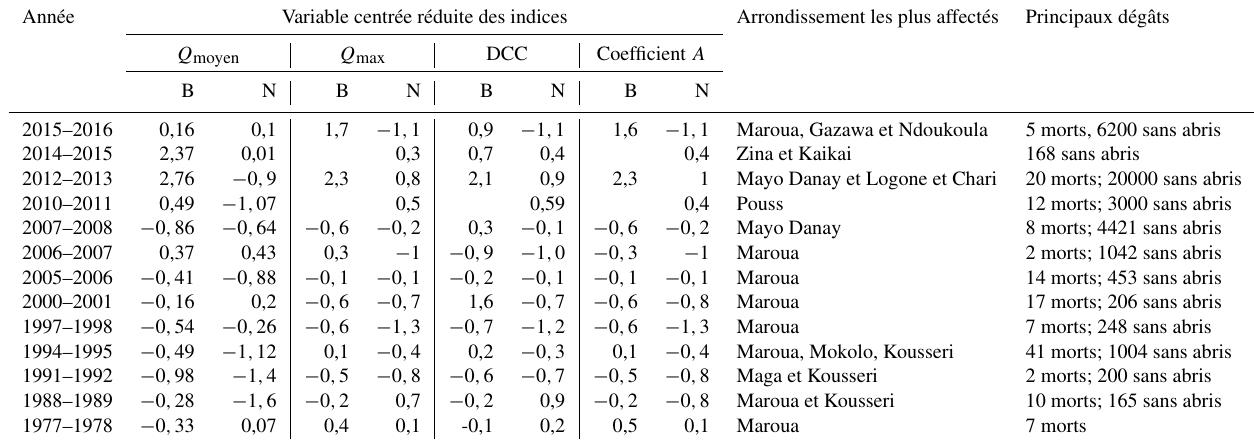
Tableau 1. Facteurs hydrologiques et inondations majeures dans la région de l’Extrême-Nord du Cameroun. Année Variable centrée réduite des